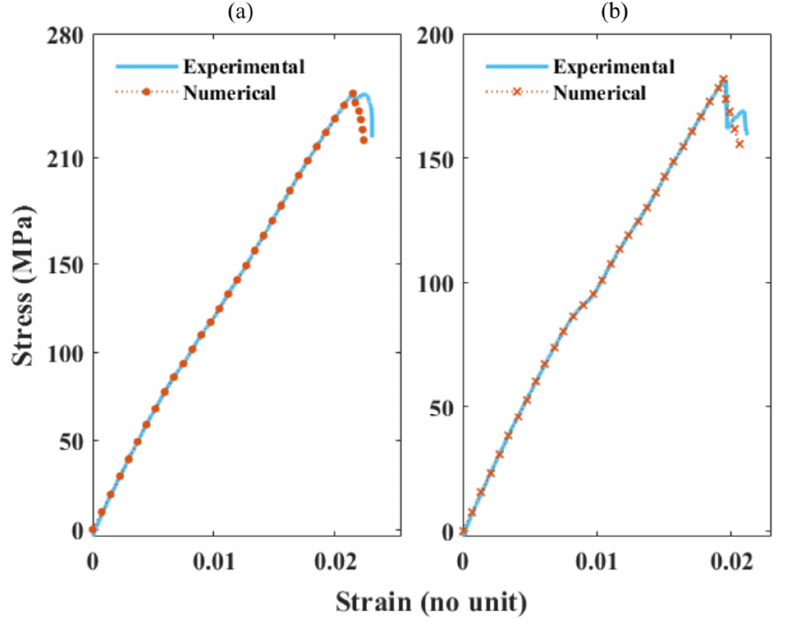
Figure 10. Comparing experimental and numerical SS curves of rCF/EP composites: ( a ) SS curves of 60% rCF/EP; ( b ) SS curves of 40%